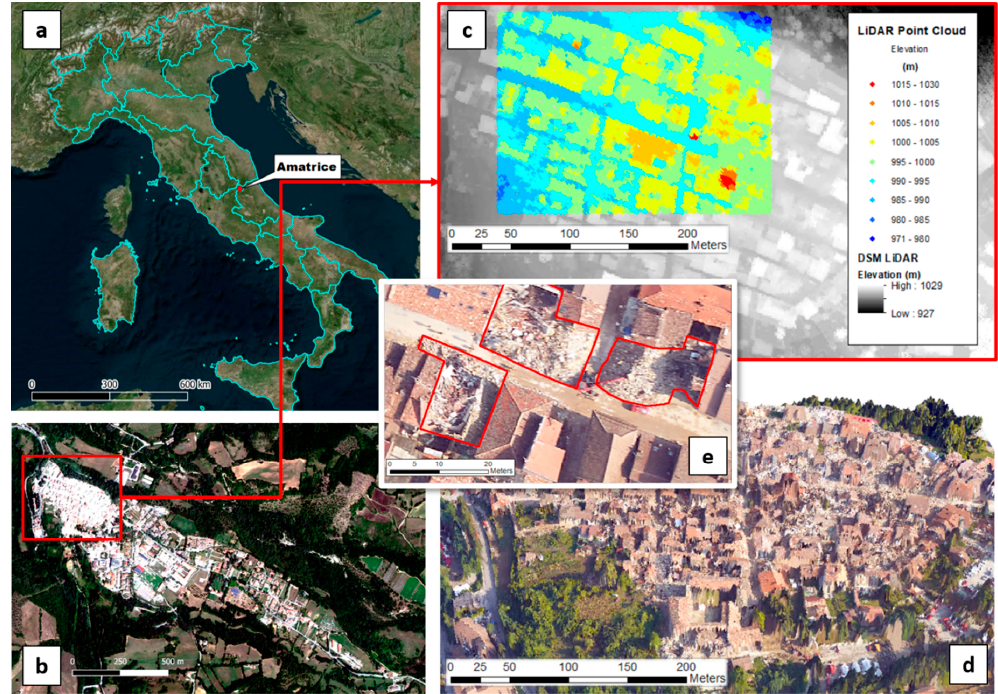
Figure 1. ( a ) Amatrice location (Central Italy); ( b ) WorldView-3 image (Amatrice inner city within the red box); ( c ) Example of LiDAR Point Cloud coverage and derived DSM; ( d ) Amatrice inner city post-event 3-D rendering (DSM derived from LiDAR Point Cloud and orthophotos textures); ( e ) Example of rubble heap delimitation within